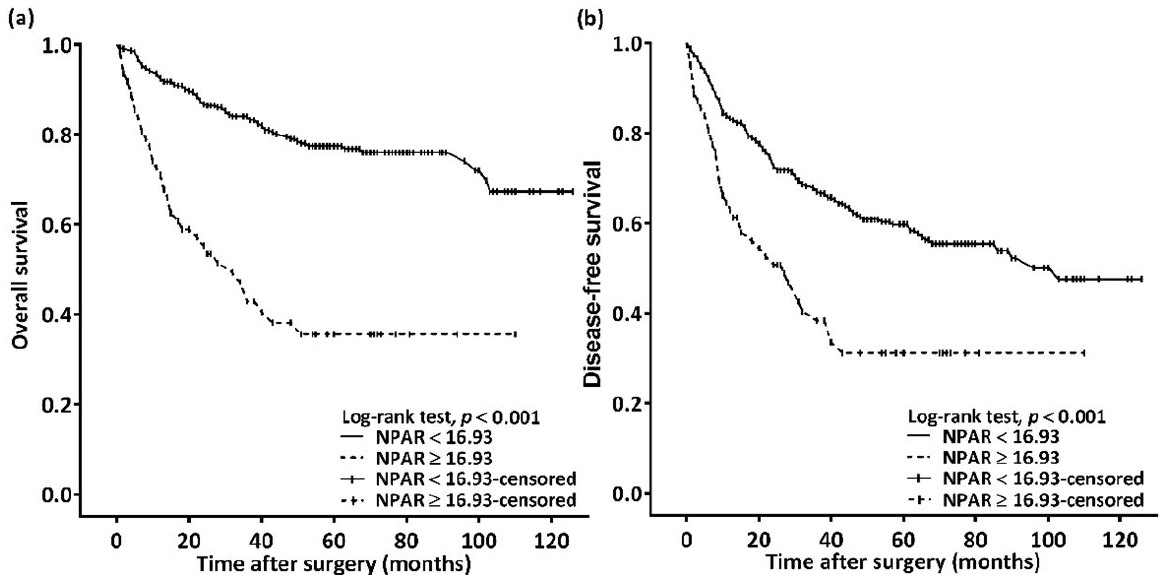
Figure 2. ( a ) Overall survival and ( b ) disease-free survival Kaplan–Meier curves for patients with oral squamous cell carcinoma classified on the basis of preoperative NPAR. Prognosis was significantly poorer in patients with an NPAR of ≥ 16.93. Abbreviation: NPAR, neutrophil percentage-to-albumin